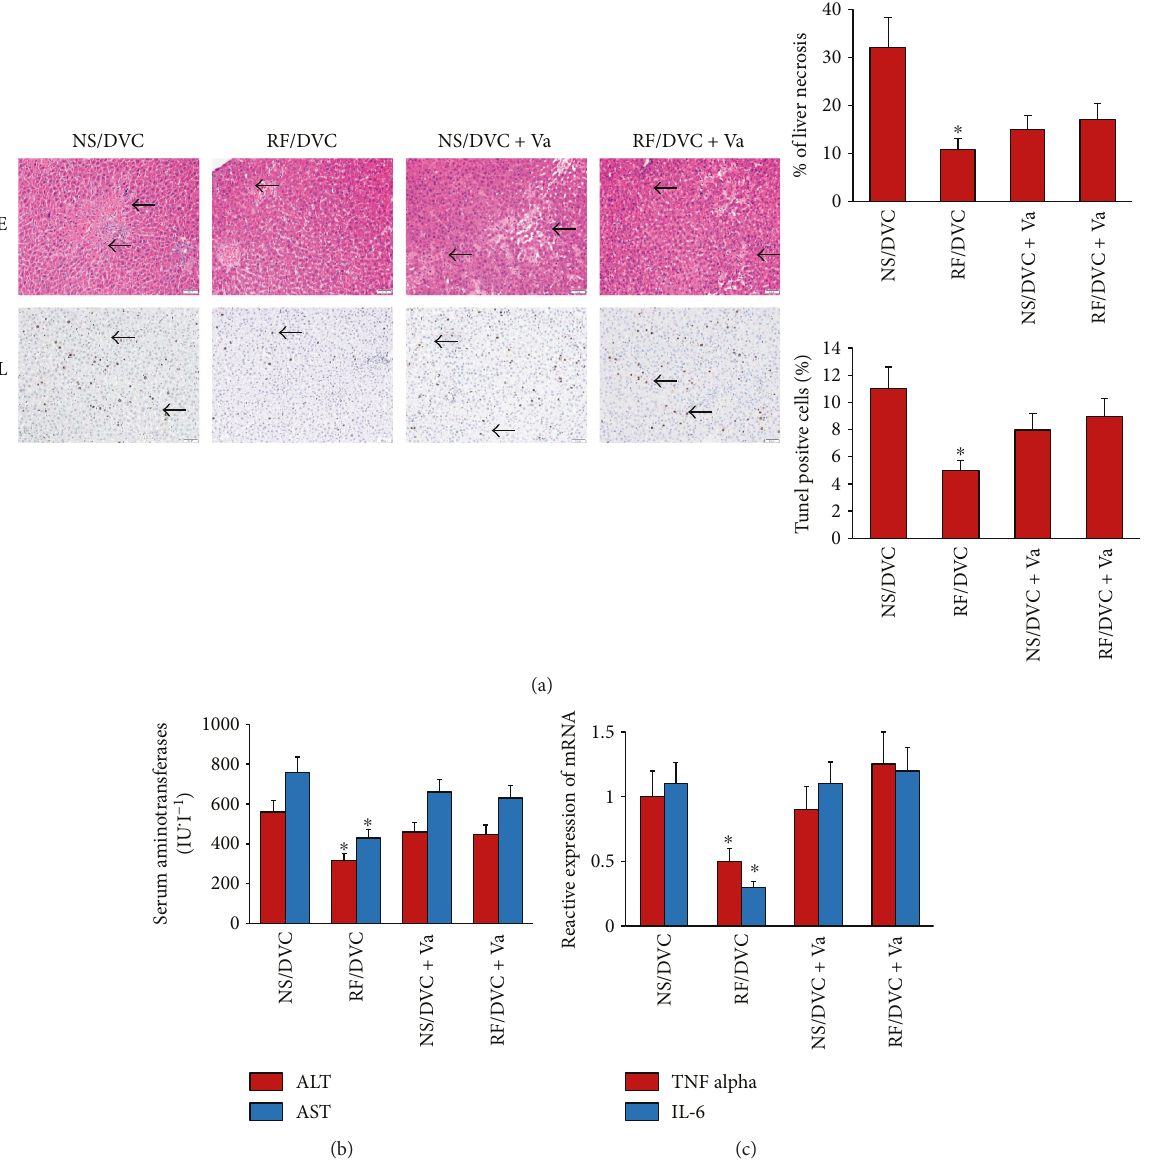
Figure 4: Microinjection of remifentanil in DVC alleviated hepatic ischemia reperfusion injury but abolished by vagotomy. Rats were divided into 4 groups with or without vagotomy and then injected with 1 μ g of remifentanil or normal saline into DVC. Hepatic IR was induced 10minutes after the treatment above with ischemia for 45minutes and 120-minute reperfusion. n = 8 in each group. (a) Photograph depicting a typical pattern of focal necrosis (black arrows) after ischemic degeneration of hepatocytes around the central venous area showed that histologic damage was signi fi cantly decreased when injected with remifentanil into DVC (RF/DVC) but not in the NS/DVC and RF/DVC+ Va groups. Hepatocyte apoptosis determined by TUNEL staining indicated that hepatocyte apoptosis was signi fi cantly decreased in the group with DVC injection of remifentanil (RF/DVC) without vagotomy (magni fi cation: 200x; ∗ P < 0 05 versus NS/DVC, NS/DVC +Va, and RF/DVC+Va groups). (b) Serum alanine aminotransferase (ALT) and aspartate aminotransferase (AST) were signi fi cantly decreased in the group with DVC injection of remifentanil (RF/DVC) than in the NS/DVC and RF/DVC+ Va groups ( ∗ P < 0 05 versus NS/DVC, NS/DVC +Va, and RF/DVC +Va groups). (c) TNF- α and IL-6 mRNA expression measured by quantitative real-time PCR were lower in the group injected with remifentanil into DVC (RF/DVC) compared with the NS/DVC and RF/DVC+ Va groups ( ∗ P < 0 05 versus NS/DVC, NS/DVC+ Va, and RF/DVC+Va